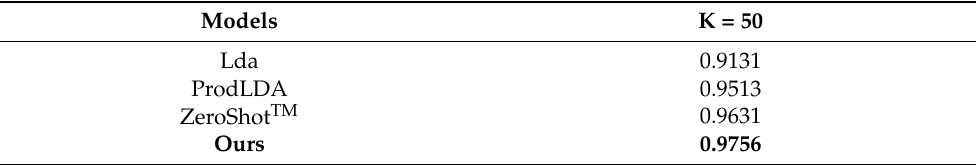
Table 4. Comparison of topic diversity (RBO cepstral) scores of different models.